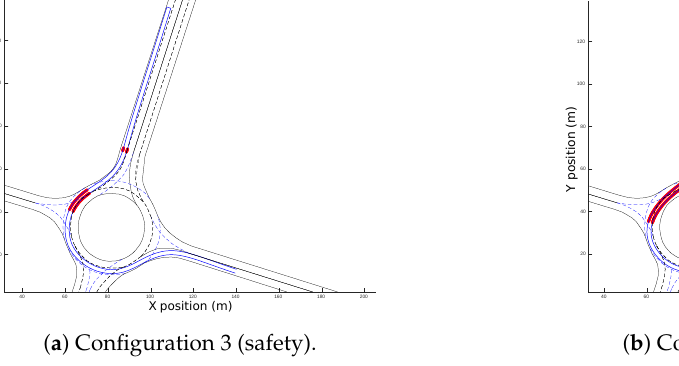
( a ) Configuration 3 (safety). ( b ) Configuration 5 (utility). Figure 18. Lane invasion for the simulated